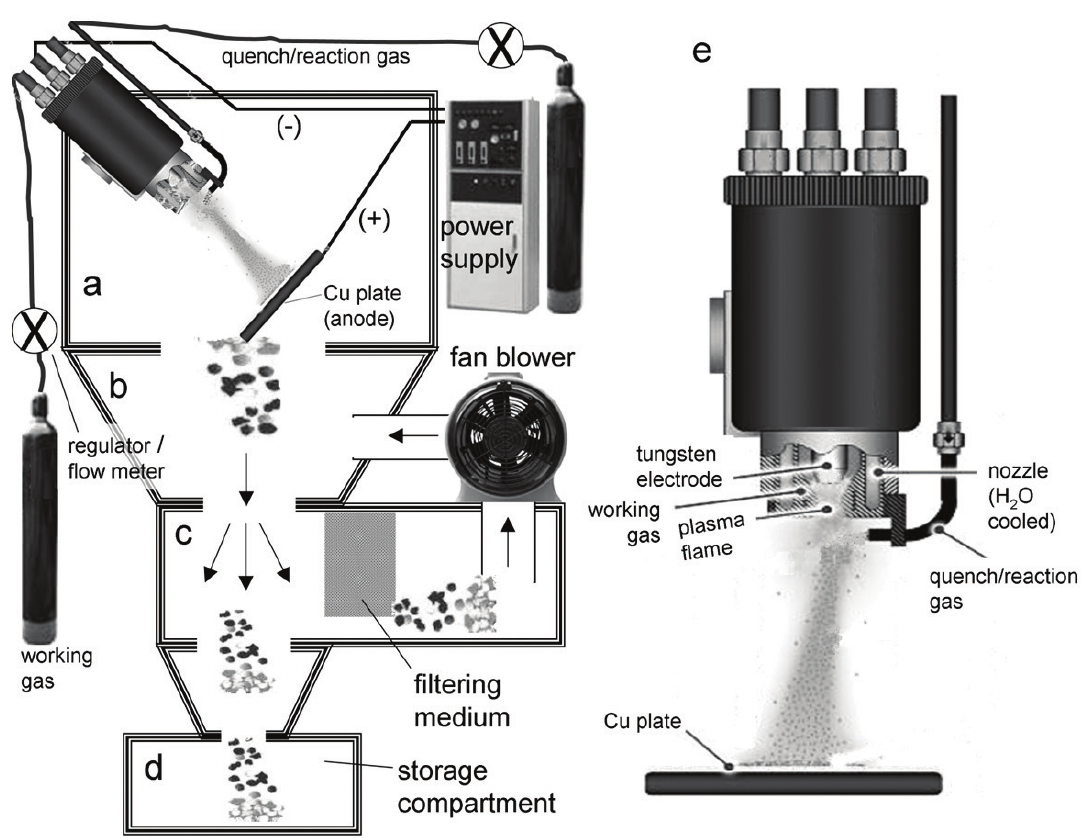
Figure 1. Schematic of the plasma spray setup. a) Plasma arc and atomizer, b) powder collecting cone, c) air recirculating and filtering compartment, d) storage compartment and d) close up view of the